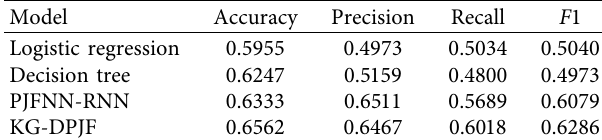
Table 6: The comparative experiment with structured data one hot.